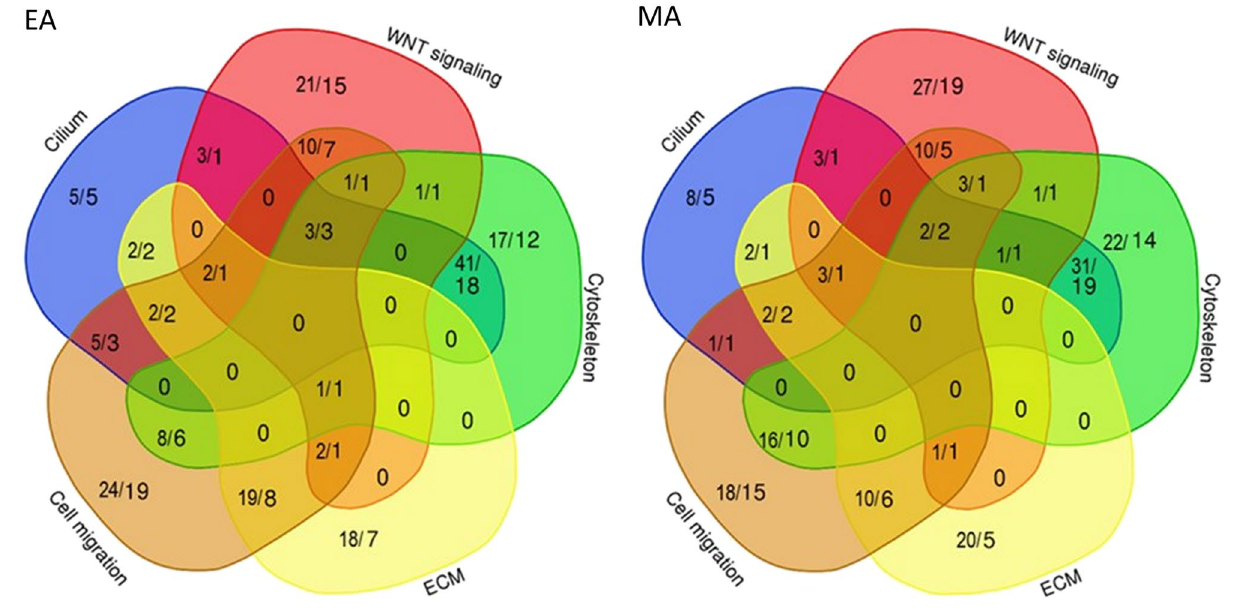
Figure 5. URDV containing candidate genes involved in multiple ontology groups. The Venn diagrams showed the relation and distribution of UTDV count and NTD candidate genes count to five ontology groups for EA ( a ) and MA ( b ). The number of URDVs and number of genes classified to cilium, WNT signaling, cytoskeleton, extracellular matrix (ECM) and cell migration are shown as fraction (count of URDV/count of gene). Genes classified to multiple categories were shown in the overlapped subset compartments between categories. Details on genes within each segment can be found in Supplementary Table